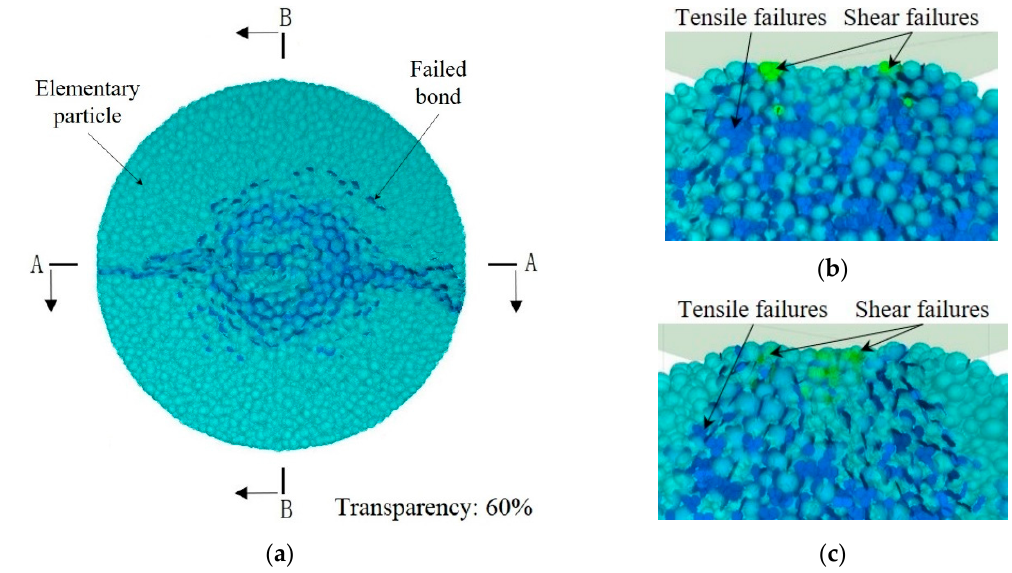
Figure 14. Morphologies after breakage: ( a ) overall breakage (top view); ( b ) partial enlargement (A-A); and ( c ) partial enlargement (B-B).